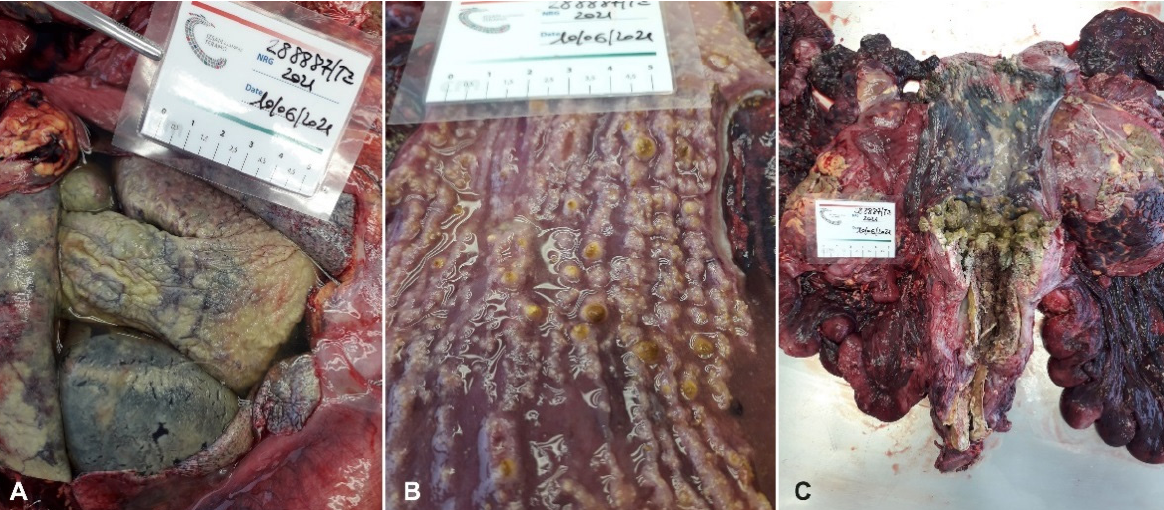
Figure 1. Pericardial effusion ( A ), yellow lamellated material and yellowish-grey warty buttons on the mucous membrane of the intestine ( B ), and enlarged ovarian follicles and bladder with serosal fibrinous plaques ( C ).